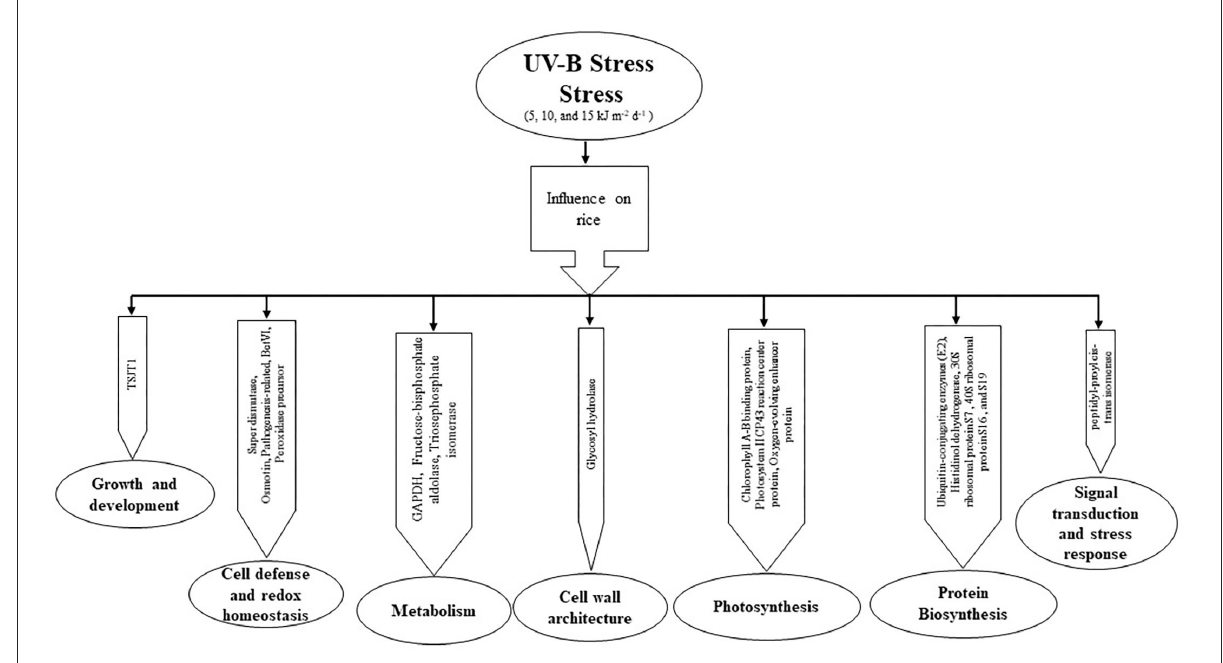
FIGURE4 The pathway of UV-B induced protein expression in the proteomic response of rice leaves to cultivars IR6 and